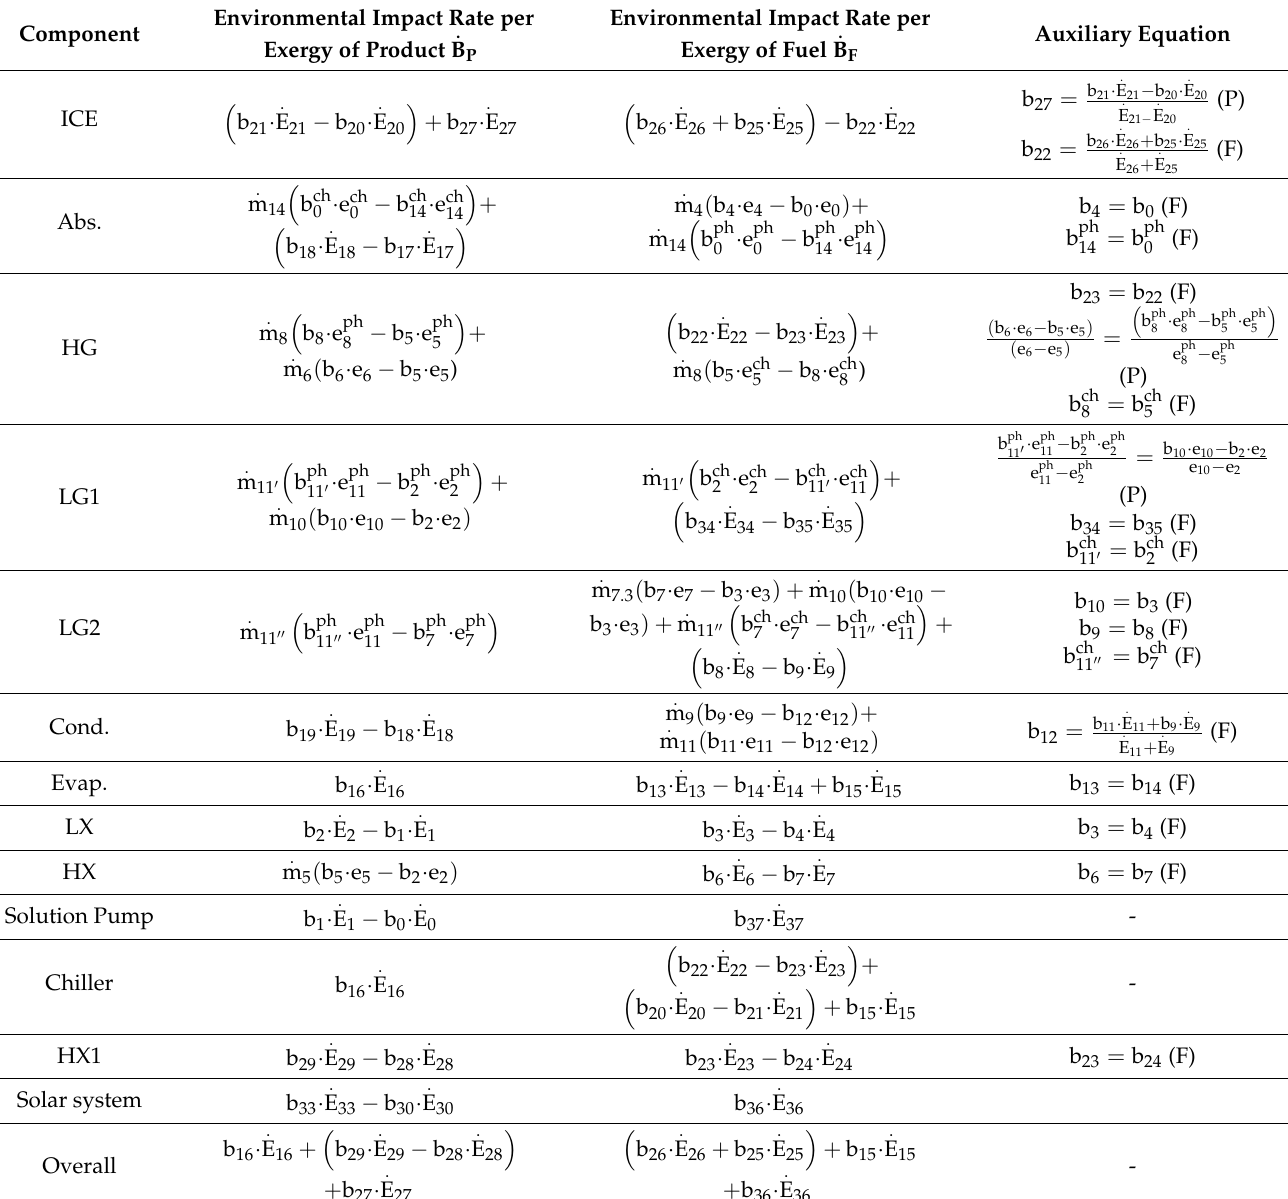
Table 1. Environmental impact rates of product and fuel, with auxiliary